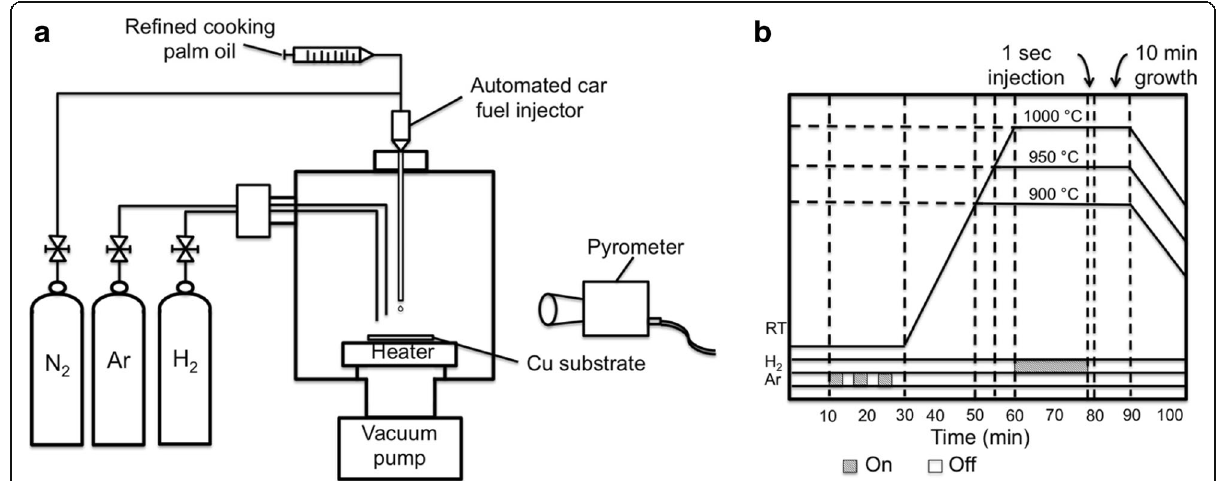
Fig. 1 a Schematic of a homemade spray injector-assisted CVD setup and b growth time